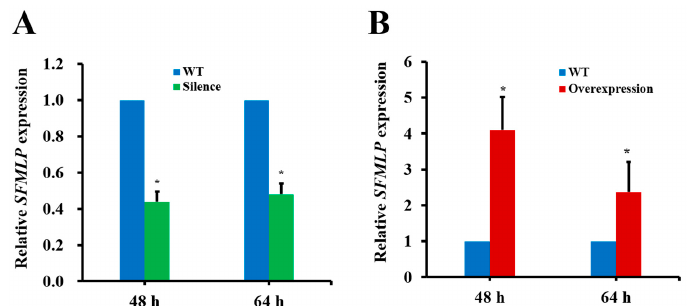
Figure 8. Relative expression levels of SFMLP in WBPHs feeding on transgenic plants. ( A ) SFMLP expression levels of WBPH feeding on SFMLP - dsRNA -transgenic plants (Silence) for 48 h and 64 h. ( B ) SFMLP expression levels of WBPH feeding on SFMLP -overexpressing transgenic plants (Over- expression) for 48 h and 64 h. * indicates statistically significant differences ( t- test: p < 0.05). Bars, ± SEM.